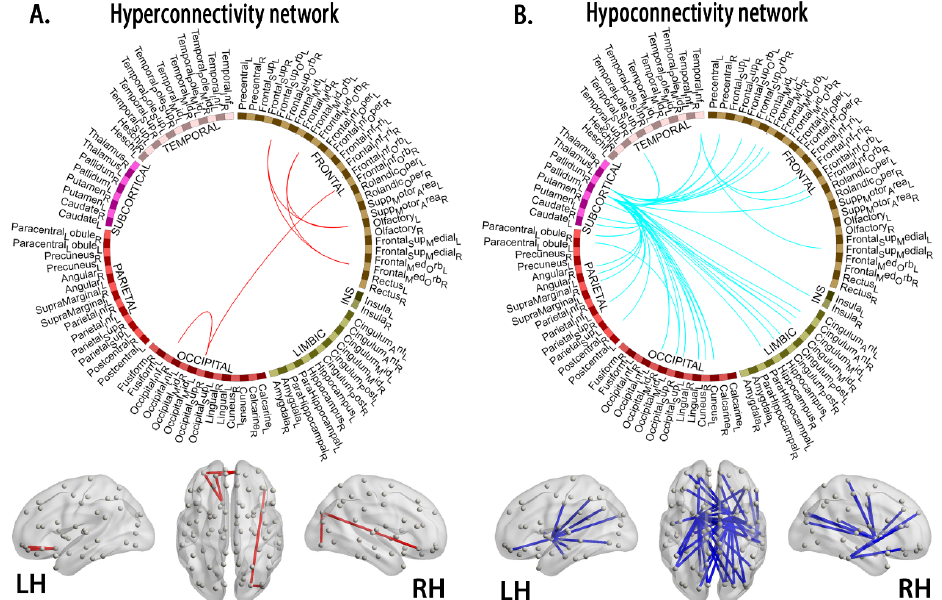
Figure 4. Compared to the healthy controls, the young survivors of ALL show network hyperconnectivity ( A , interconnected links by red lines) and hypoconnectivity ( B , blue lines). Note: ALL, acute lymphoblastic leukemia; LH, left hemisphere; RH, right hemisphere.